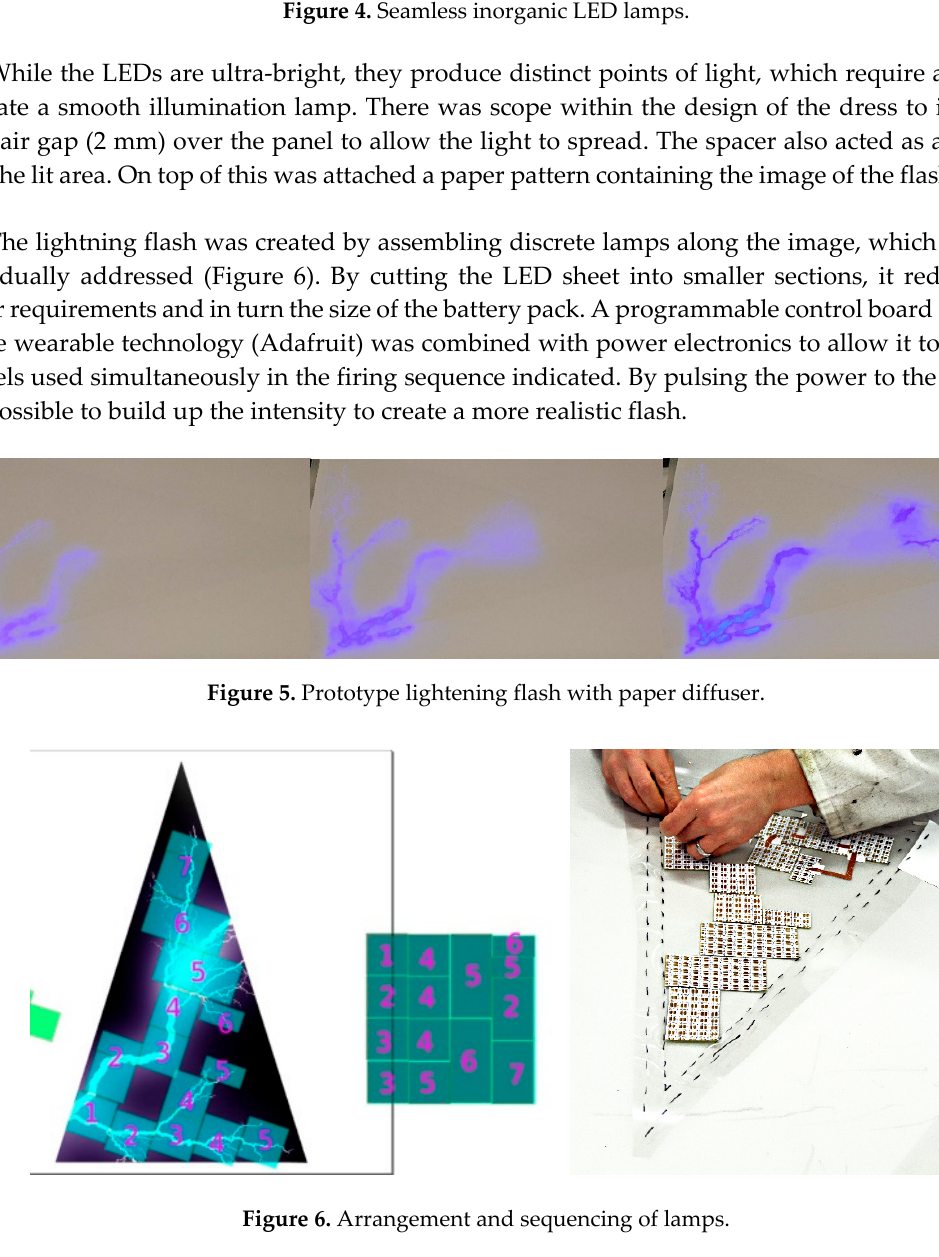
Figure 4. Seamless inorganic LED lamps.